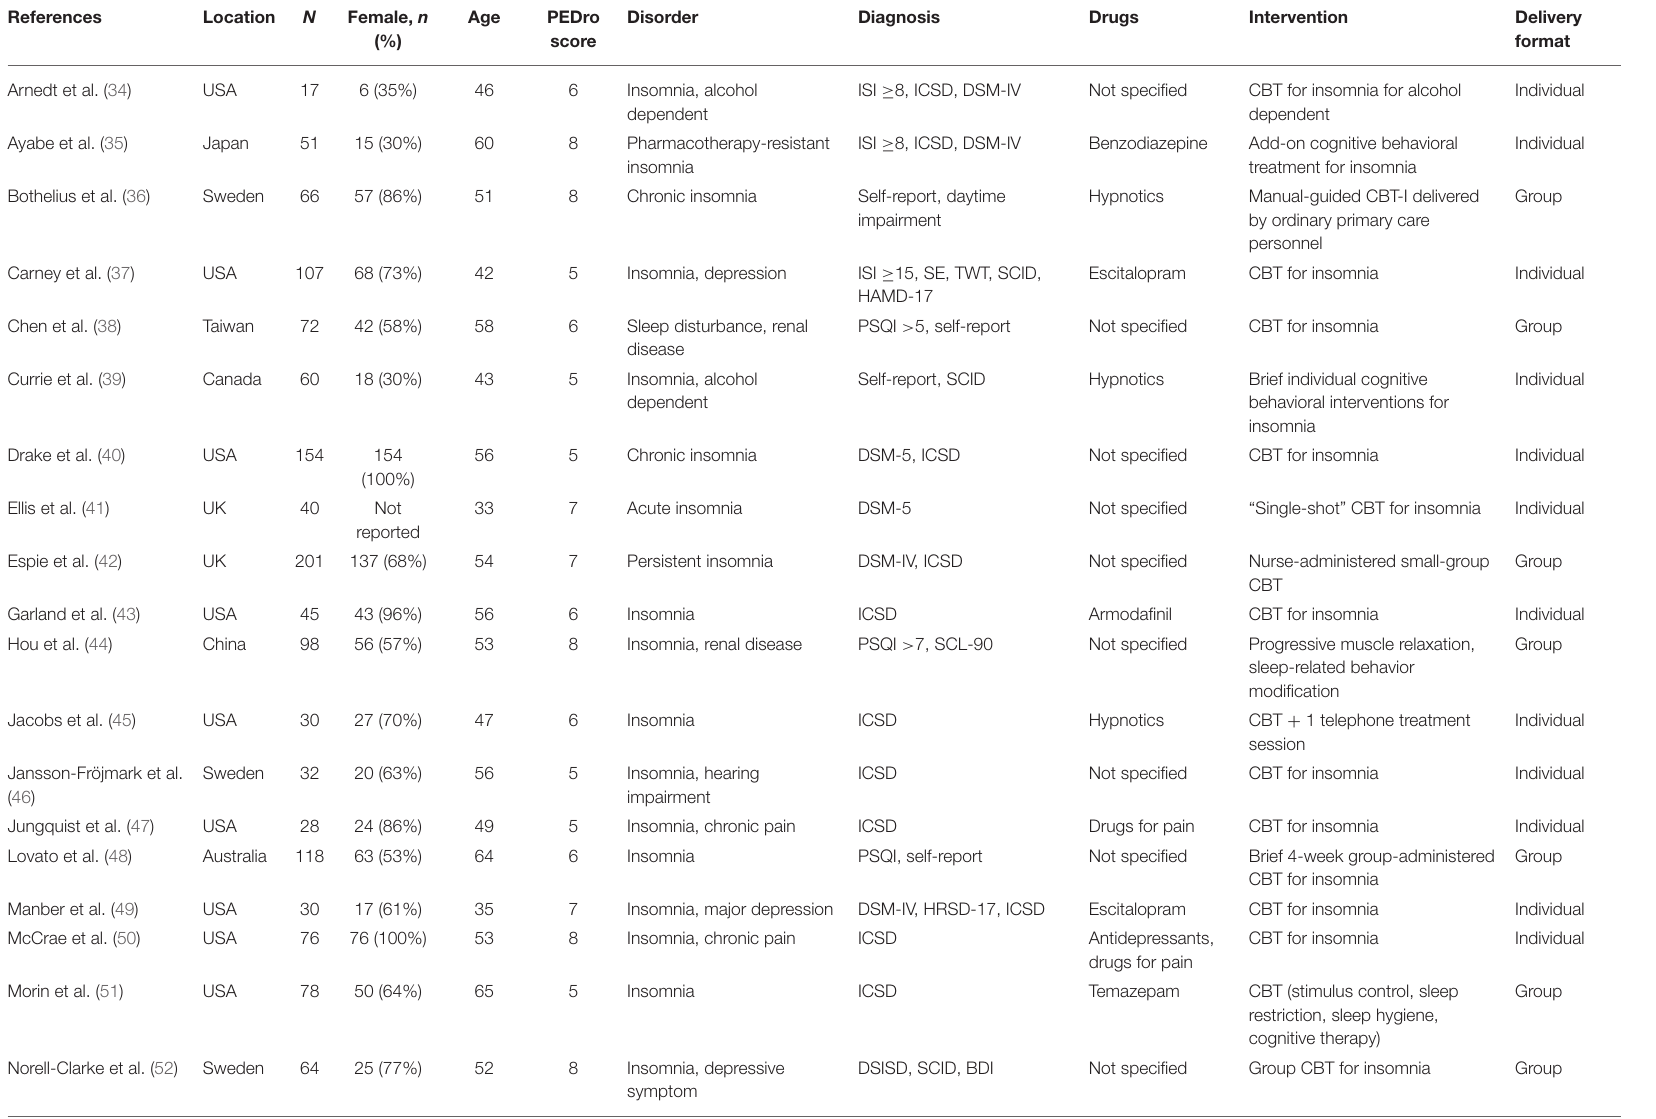
TABLE 1 | Characteristics of included